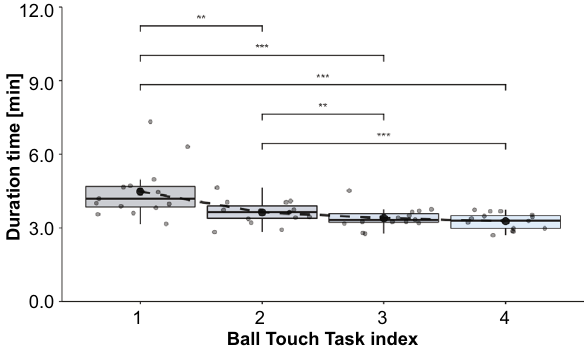
Figure 2. The duration time per set in the ball touch task. The circled markers are the results of the subjects, and the box plot shows the characteristics of the distribution of each set. *... p < 0.05 , **... p < 0.01 , ***... p < 0.001